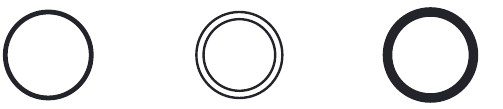
Figure 2. BPMN shapes for Start, Intermediate and End events. are executed. Other significant flows are Message Flows, which are used to show the 136 flow of messages between two separate process participants. 137